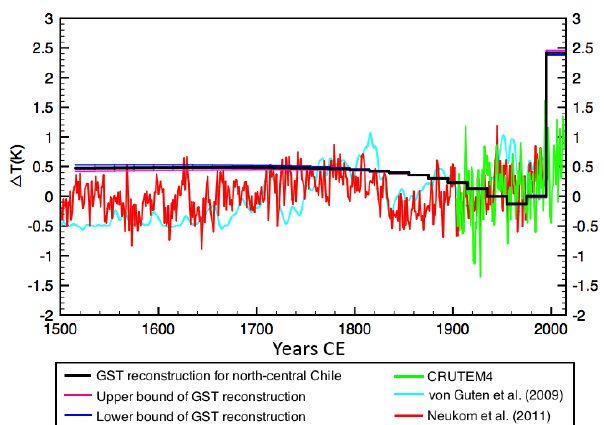
Figure 12. Comparison of GST history for north-central Chile (black) along with the upper and lower bounds of the inversion (pink and blue lines, respectively), the CRUTEM4 data for the north- central Chile grid point (green) (Jones et al., 2012), the austral sum- mer surface air temperature reconstruction from sedimentary pig- ments for the past 500 years (aqua) at Laguna de Aculeo, central Chile (von Gunten et al., 2009), and the austral summer surface air temperature reconstruction for southern South America (red) with its 2 σ standard deviation (grey shaded area) (Neukom et al., 2011). They are all presented as temperature departures from the 1920– 1940 mean.